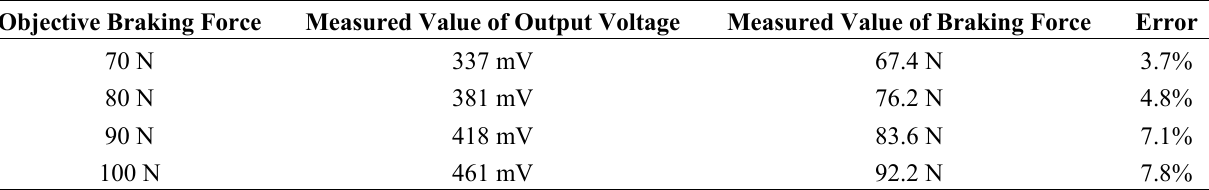
Table 3. Analysis of the experimental